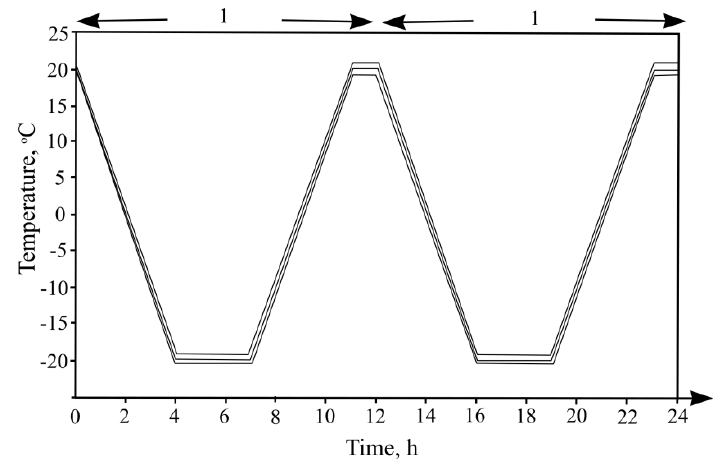
Figure 2. Sample view during frost resistance test: ( a ) view of the sample reinforced with polyester resin and fibre; ( b ) test scheme.